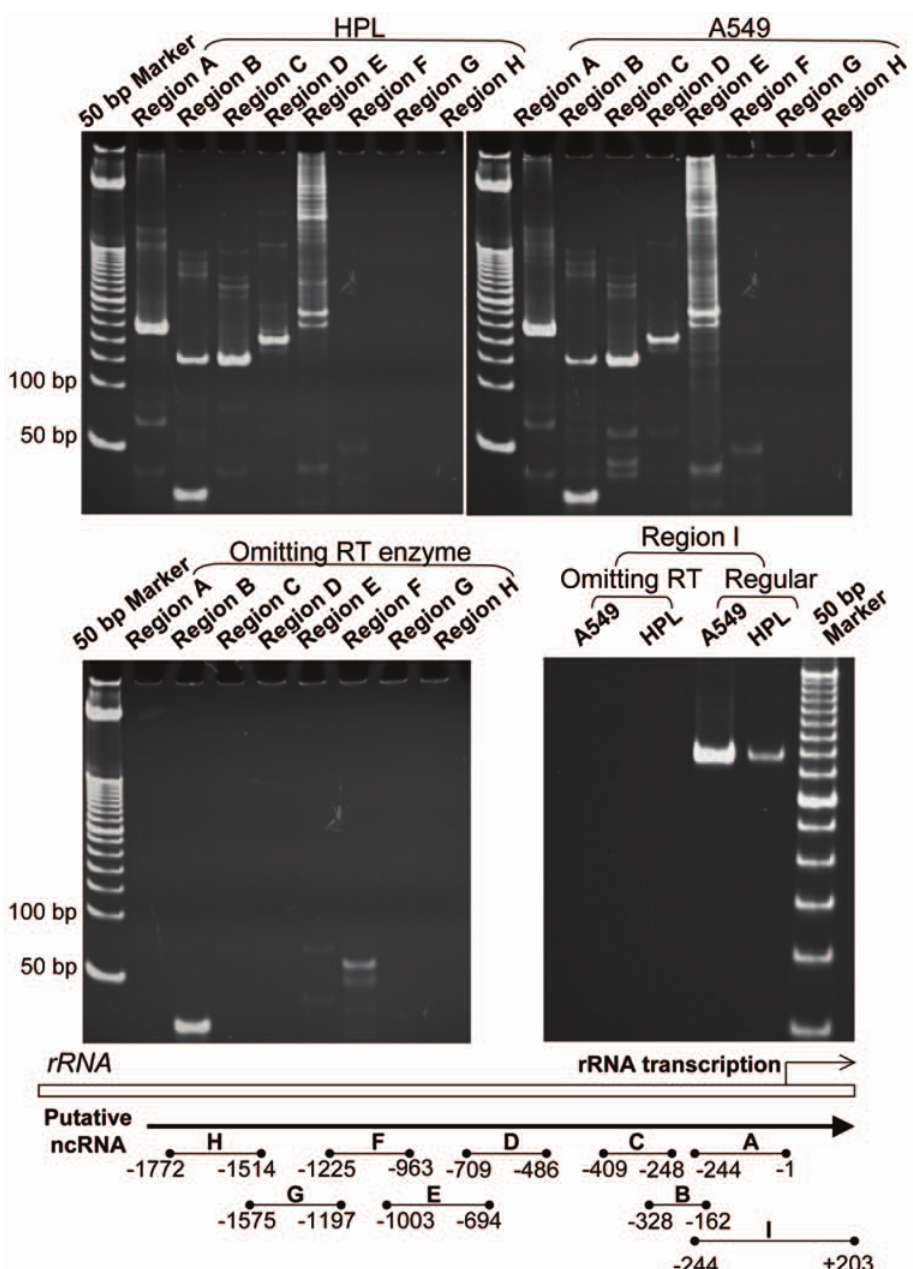
Figure 2. RT-PCR products corresponding to nc-rRNA of the human rRNA gene promoter and upstream sequences. The products were also confirmed by DNA sequencing. Representative findings are shown for cell lines HPL (immortalized non-transformed cells from human peripheral lung epithelium) and A549, a human lung adenocarcinoma cell line. Results for controls omitting the RT enzyme are shown in the lower panels. The positions amplified by specific primers are illustrated at the bottom of the figure, with + 1 being the transcription start site for rRNA. The nc-rRNA was detected between 2 1003 and + 203, but not between 2 1772 and 2 1225.